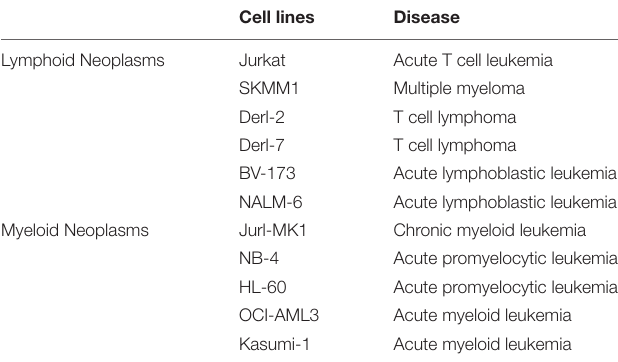
TABLE 1 | Hematological malignancies (HM) cell lines analyzed. Cell